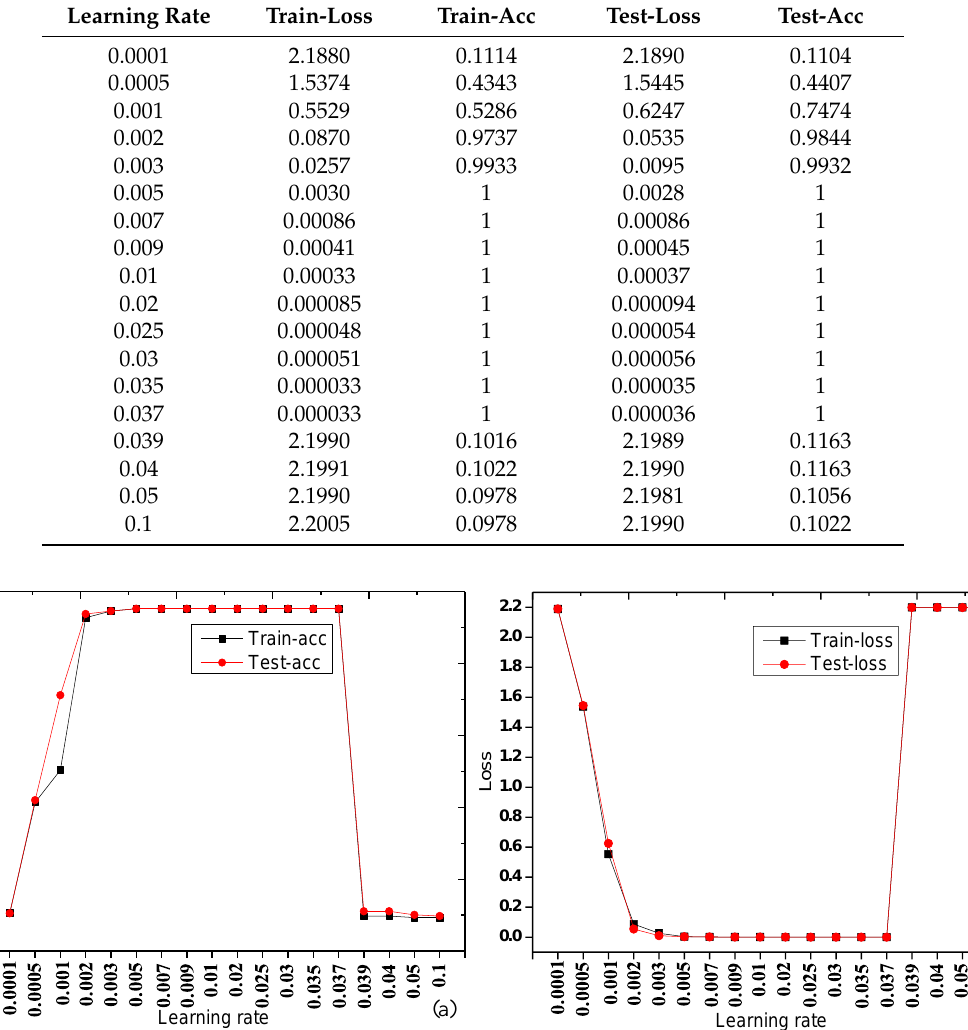
Table 5. The loss and accuracy (Acc) under different learning rates.